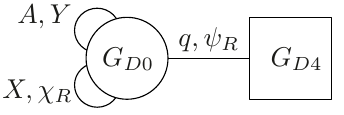
Figure 1 . 1d N = (4 ; 4) theories for the 5d N = 2